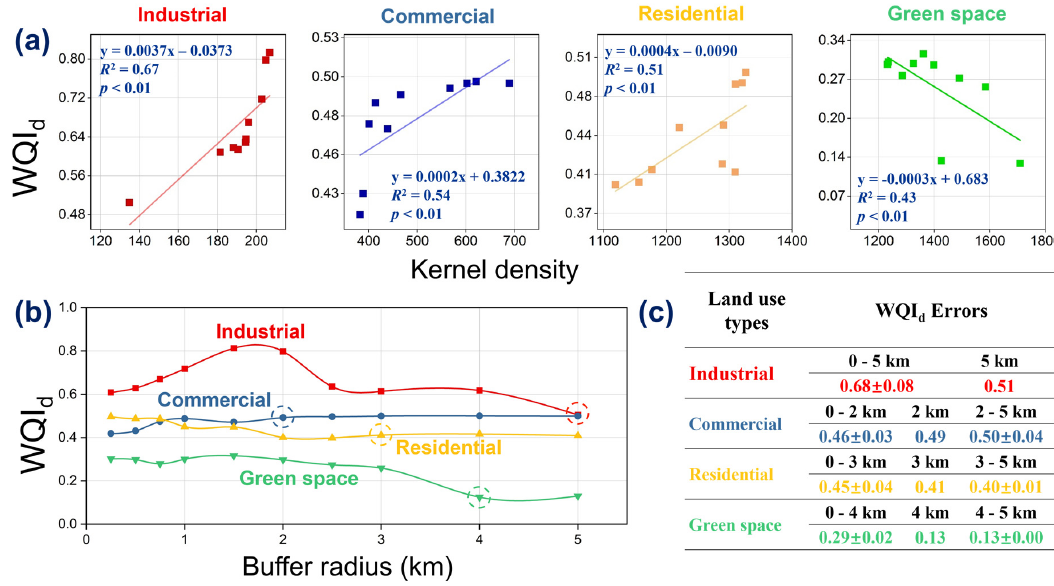
Figure 5. ( a ): Summertime water quality index (WQI d ) variations in response to kernel density of each land use type. ( b ): WQI d dynamics of each land use type along the buffer radius changes. ( c ): Error estimations for situations when selecting an inappropriate spatial extent as indicated by Figure 4b–e. We extracted values for different land use types and various buffer radii of sampled cross sections from the extrapolated WQI d map (i.e., Figure 2b).